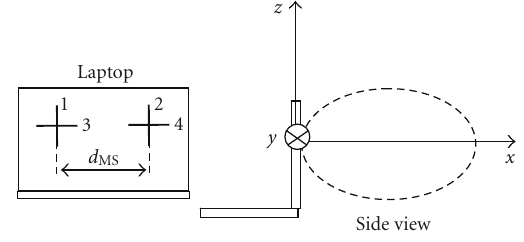
Figure 7: Laptop MS antenna configuration [22].